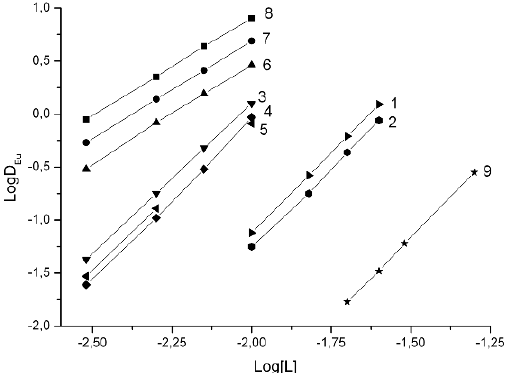
Figure 2. Influence of the concentration of the extractants 1 - 8 in 1,2-dichloroethane on the extraction of Eu(III) from 4 M NH NO solutions. The data for diphenylethylphosphine 4 3 oxide 9 are provided for comparison.